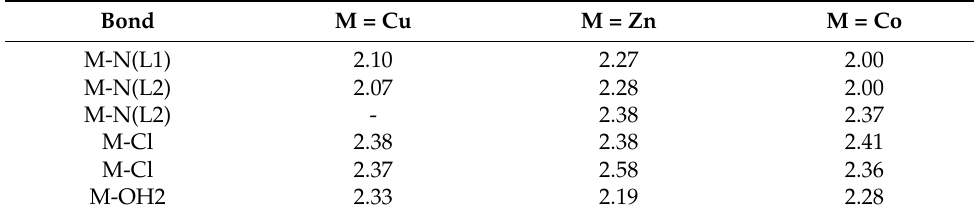
Table 2. Selected bond lengths (Å) calculated at B3LYP.